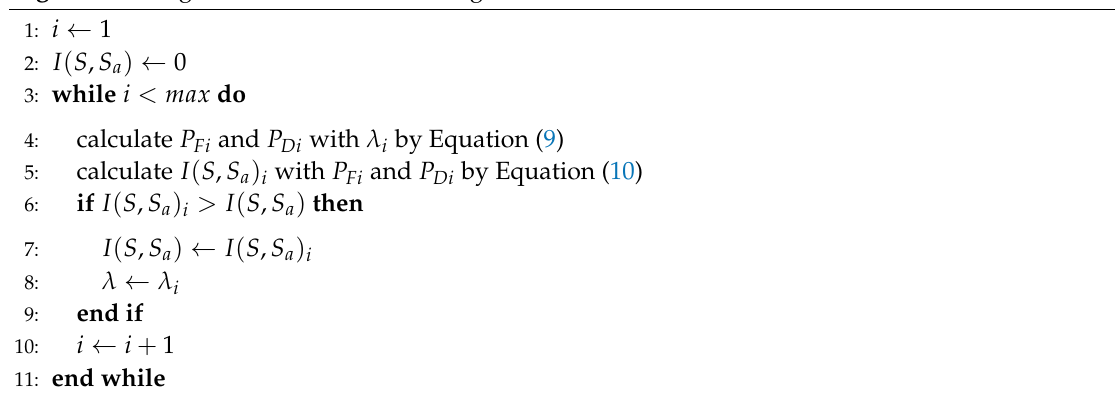
Algorithm 1 Algorithm of the thresholding